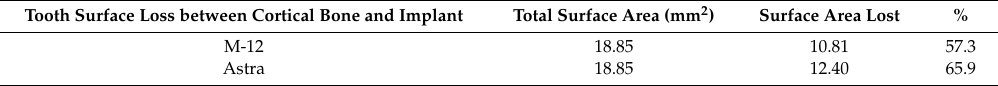
Table 3. Tooth surface loss between cortical bone and